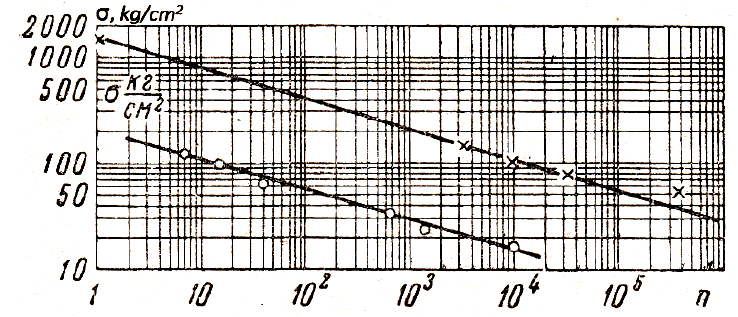
Figure A1. Comparison of the fatigue curves. × —failure due to tension, о —failure due to contact interaction. Material: SBR European.